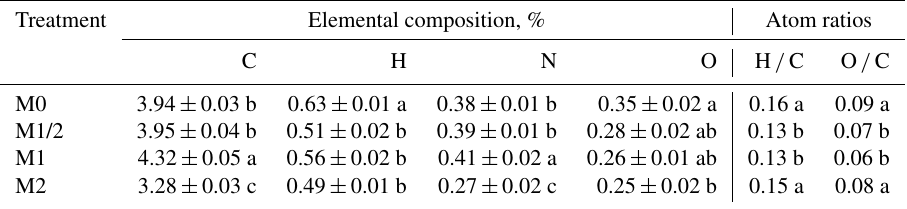
Table 4. Elemental composition of SOM from surface soils in grassland soil with different mowing frequencies. Treatment Elemental composition, % Atom ratios